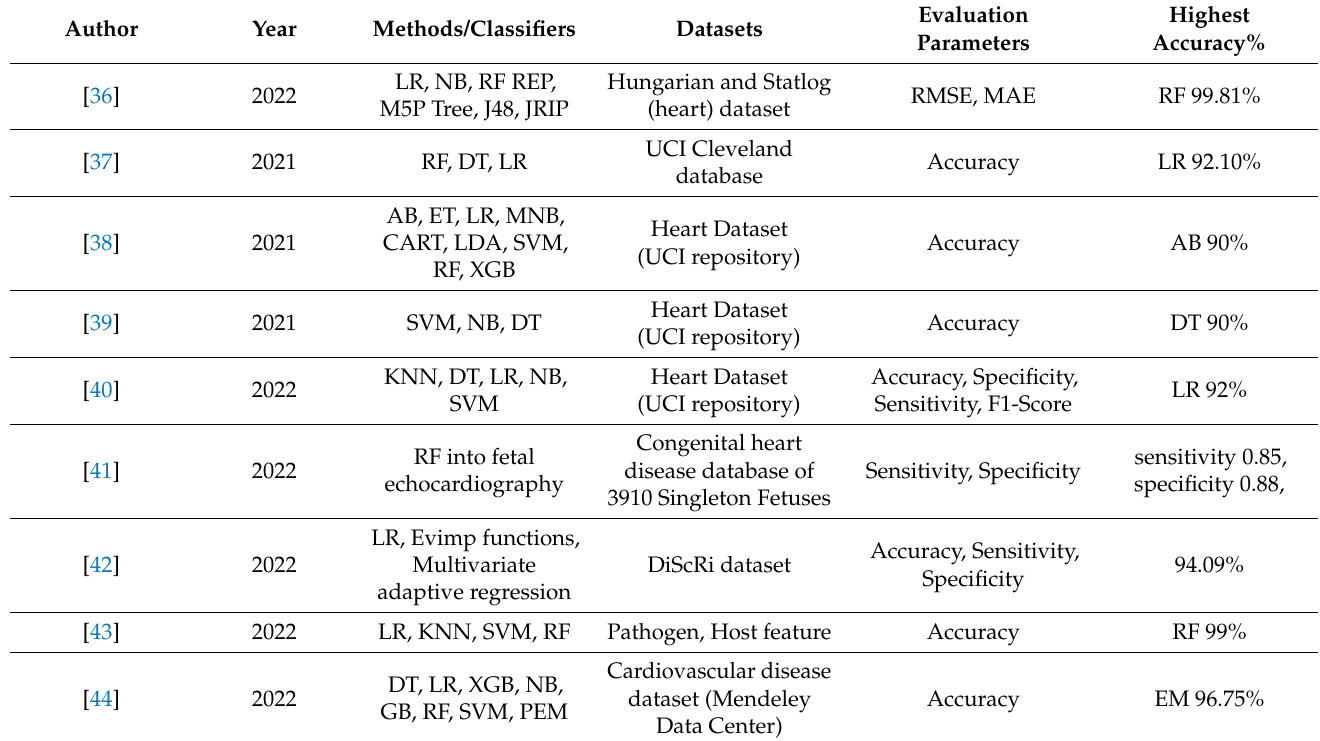
Table 1. State of the